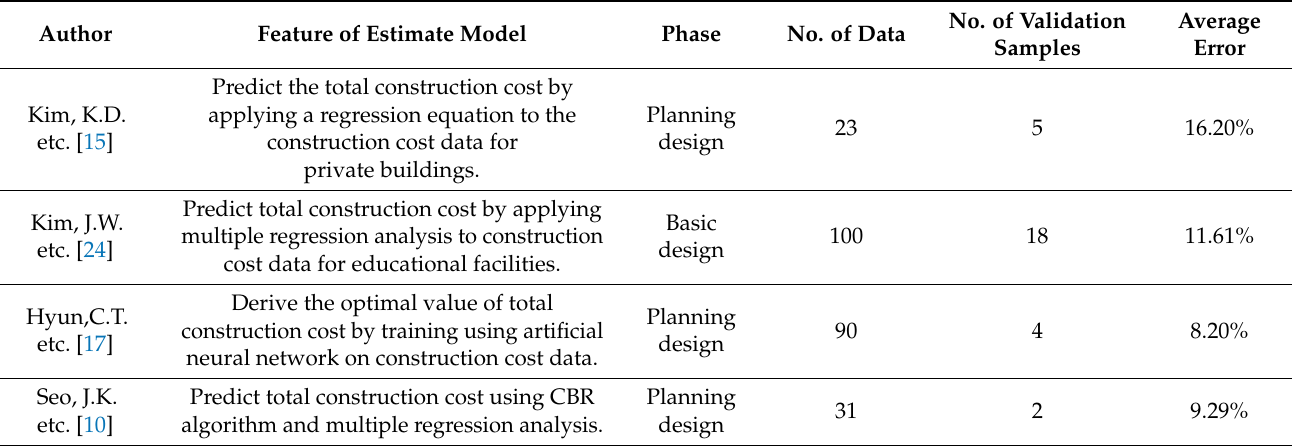
Table 2. Characteristics of the prediction model composition of the analyzed previous